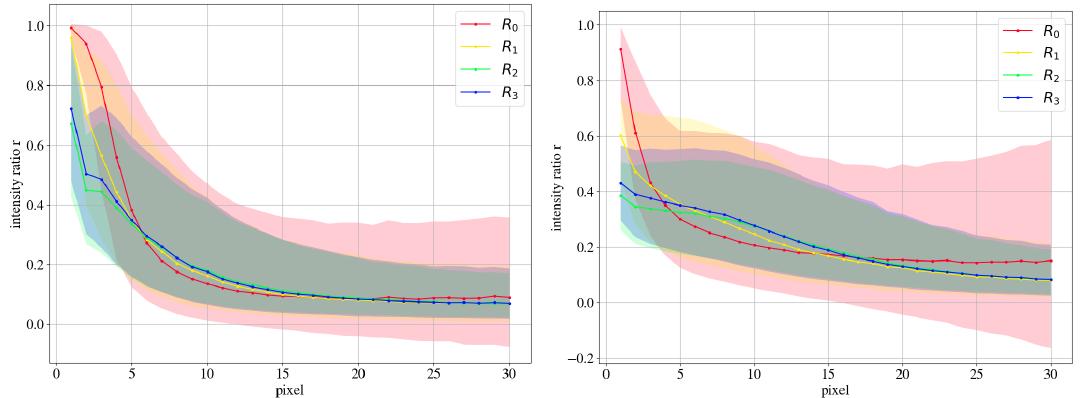
Figure 11 . Same as figure 9 but for training with KMSE loss. Results are shown for QCD jets (left) and top jets